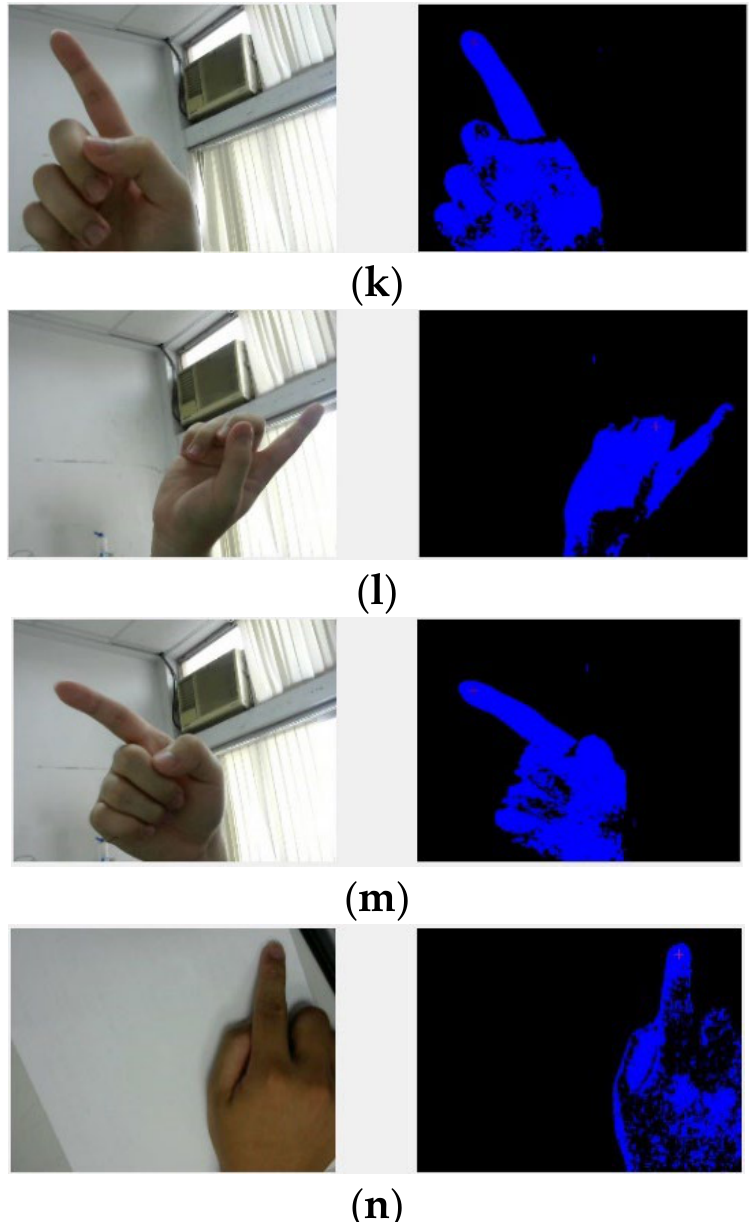
Figure 14. Different finger gesture command parameter identification in various situations: ( a ) Up, ( b ) Down, ( c ) Middle, ( d ) Right, ( e ) Upper right, ( f ) Lower right, ( g ) Left, ( h ) Upper left, ( i ) Lower left, ( j ) Up, ( k ) Upper left, ( l ) Upper right, ( m ) Left, ( n ) Upper right .